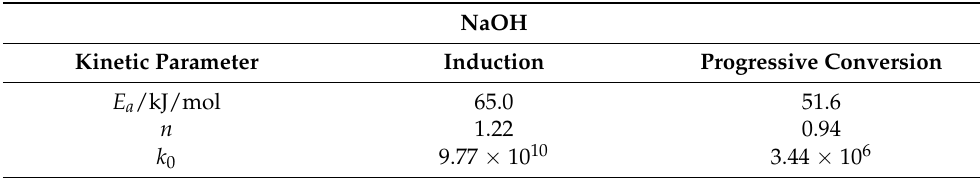
Table 6. Kinetic parameters calculated for the decomposition of ammonium-sodium jarosite with arsenic in NaOH